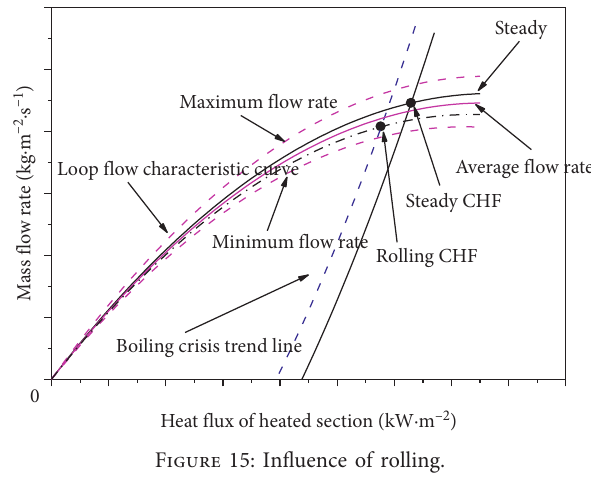
Figure 15: Influence of rolling.